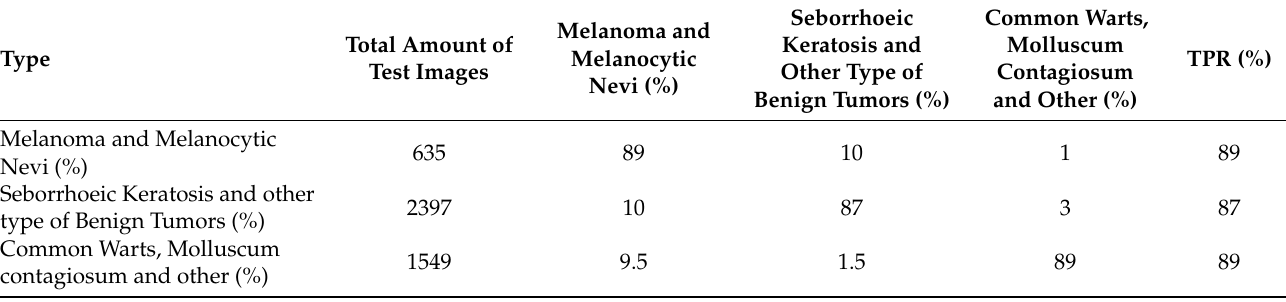
Table 10. Dermnet dataset confusion